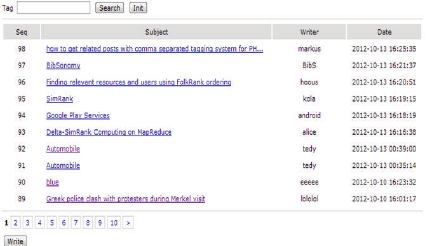
Figure 8: Bulletin list written by a